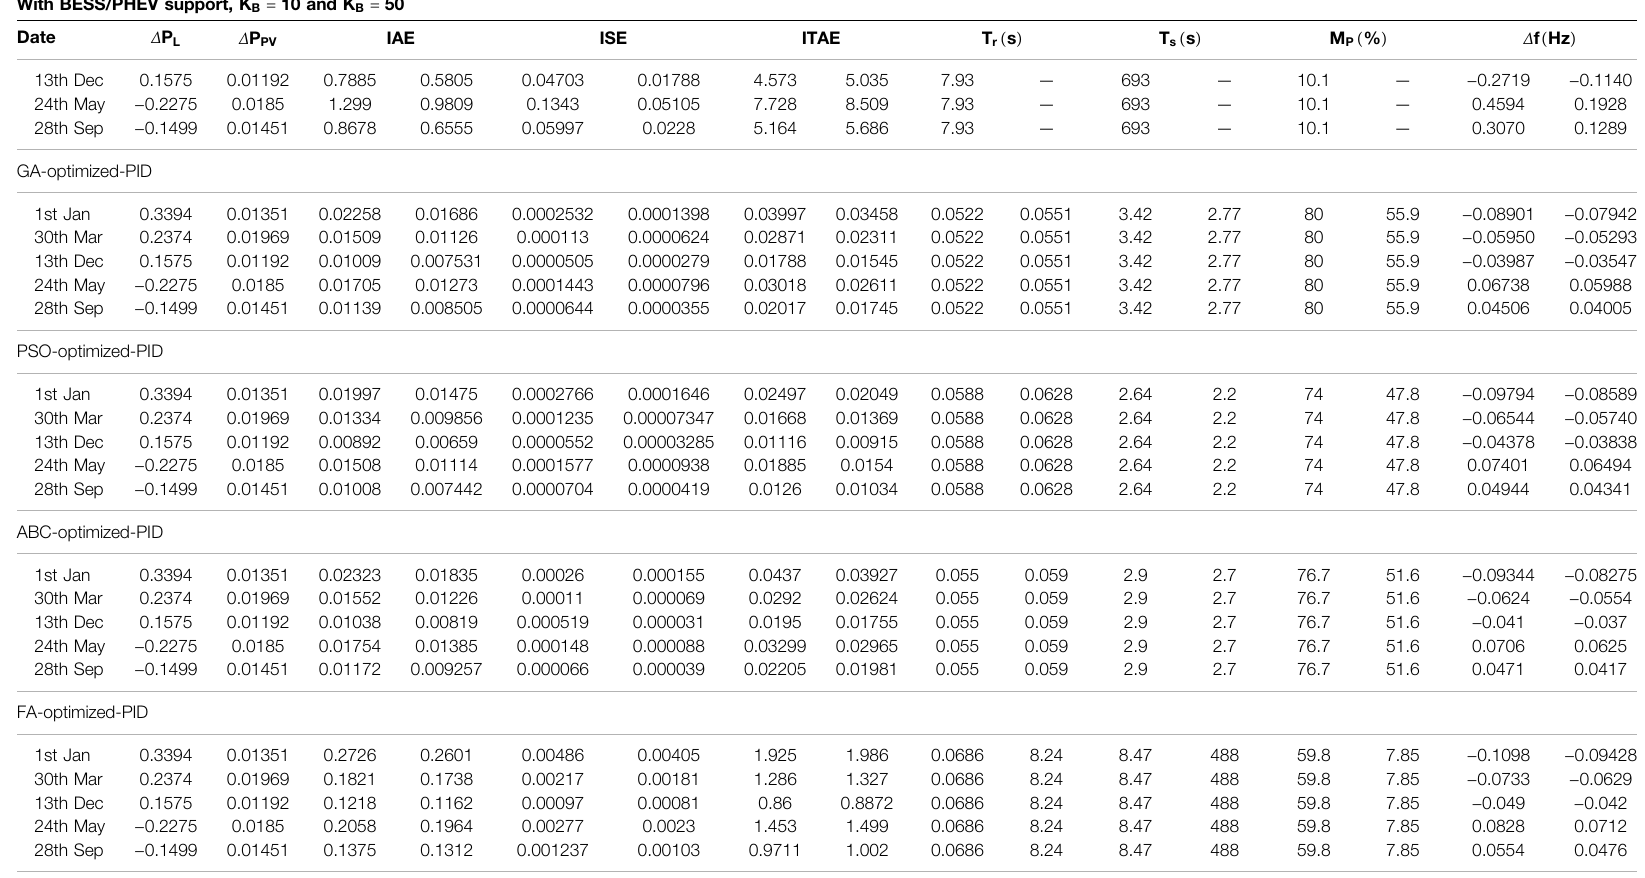
TABLE 7 | ( Continued ) Frequency deviation parameter indices using integral square error objective